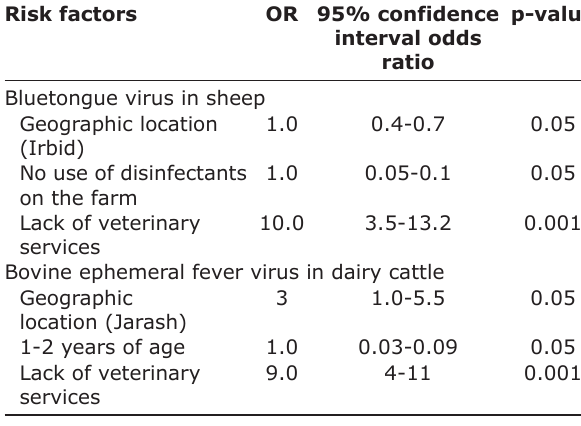
Table-3: Multivariate logistic regression analysis of risk factors associated with high seropositivity against bluetongue virus in sheep and bovine ephemeral fever virus in dairy